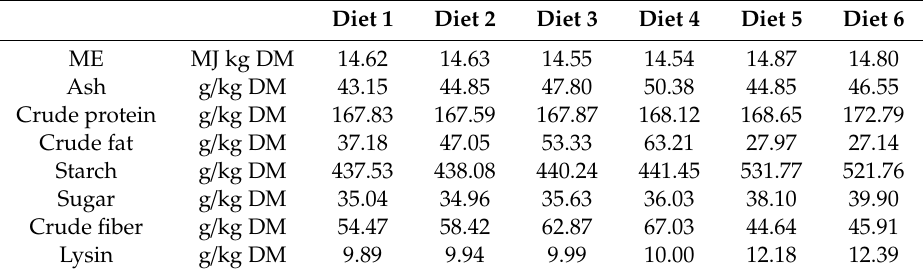
Table 4. Calculated energy and nutrient contents per kg of dry matter in all diets for Barns